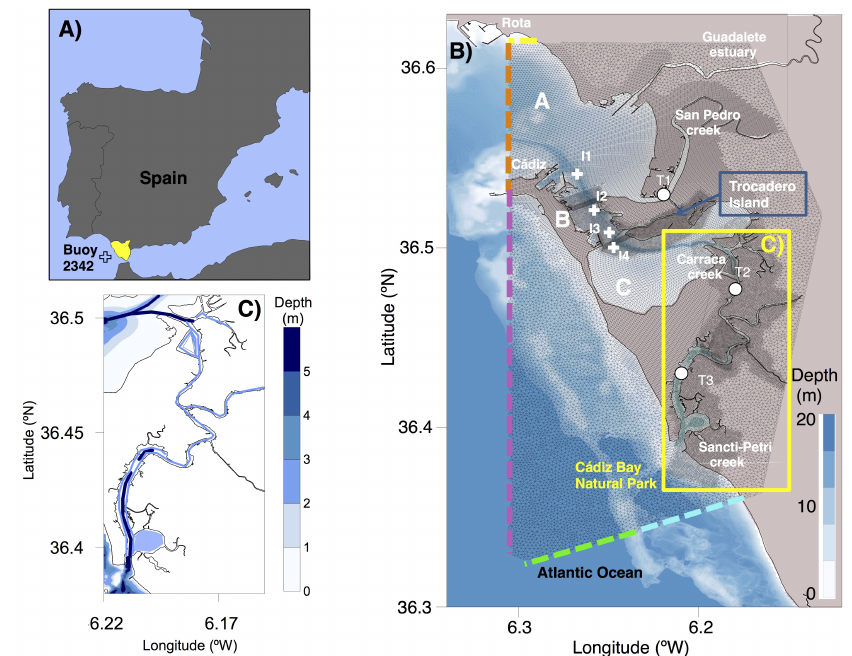
Figure 1. ( A ) Location of the Cádiz Bay in Spain; ( B ) Computational grid and color coded bathymetry of the Cádiz Bay with the locations of the stations (labels I1–I4 correspond to current profile meters (marked with white crosses), and labels T1–T3 to tidal gauges (marked with white circles) where data were collected). Dashed color lines correspond to the five boundaries of the mesh. The Cádiz Bay Natural Park includes the square yellow (more detail in panel ( C ) and the Trocadero Island (blue square); ( C ) Detailed bathymetry of the creek network.